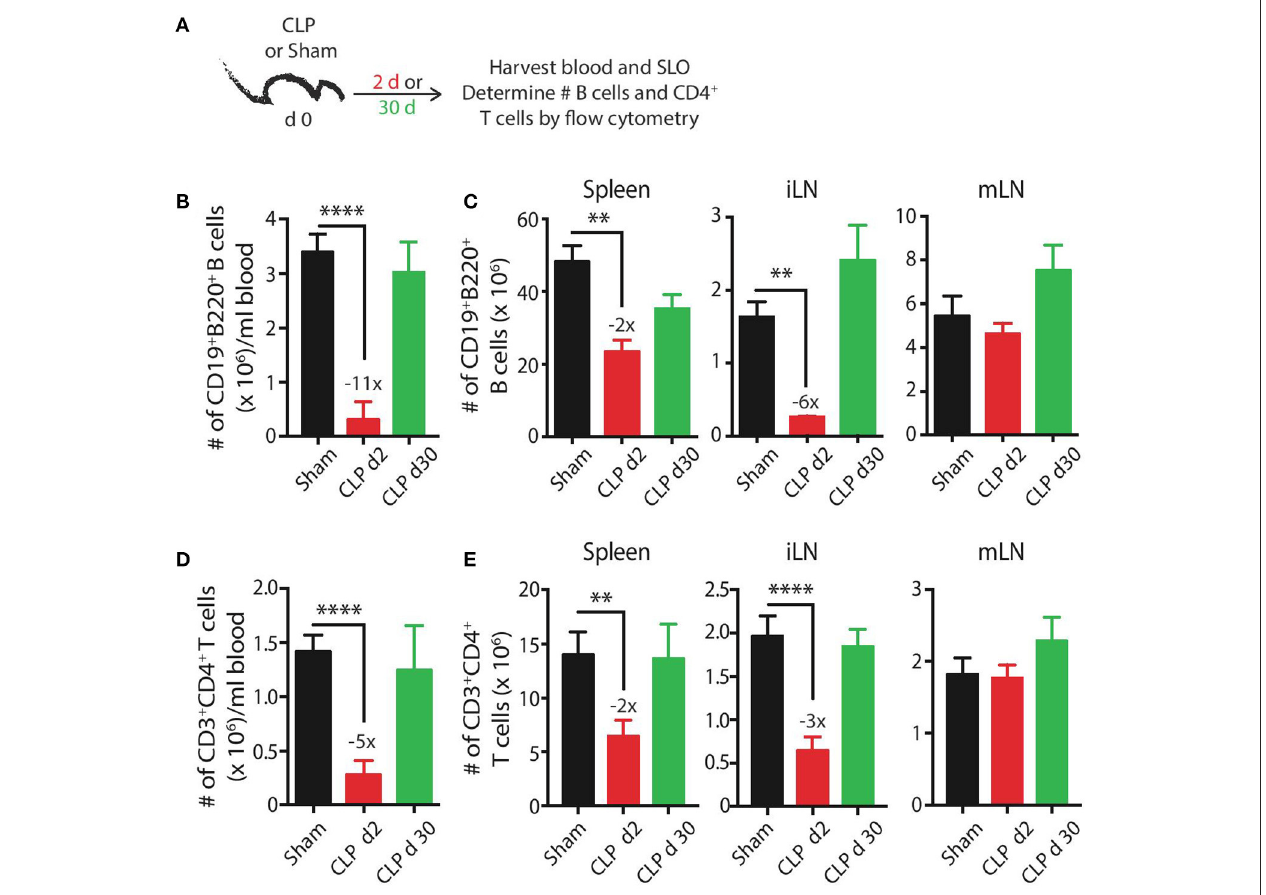
FIGURE 1 | CLP induces transient reductions in the number of B cells and CD4T cells . (A) Experimental design—blood and secondary lymphoid organs (SLO) including spleens, inguinal lymph nodes (iLN), and mesenteric lymph nodes (mLN) were harvested 2 and 30 days after sham or CLP surgery. The number of